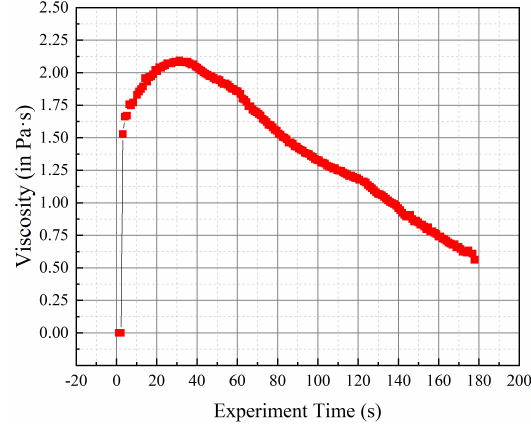
Figure 4. The viscosity of SiC by